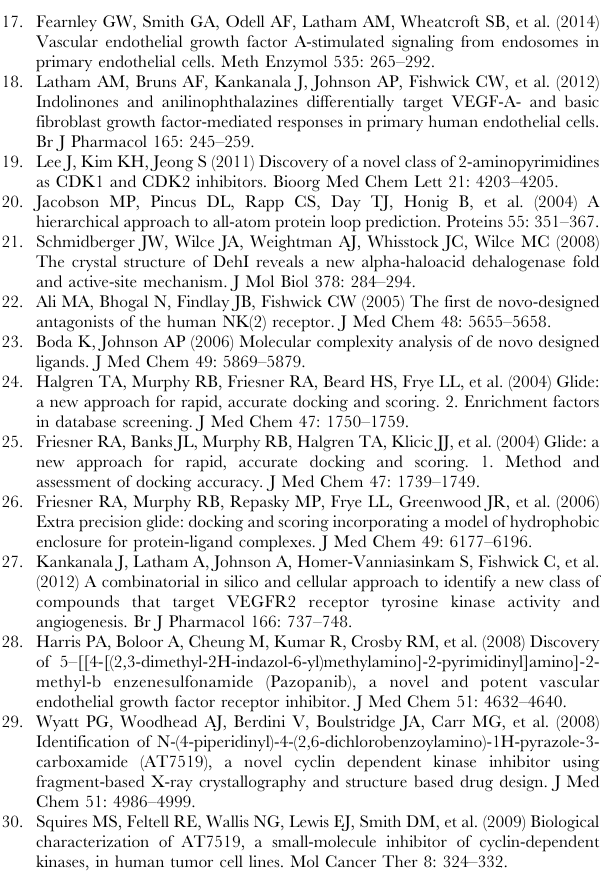
or (B) IGF-1-mediated signaling in endothelial cells. HUVECs were pre-treated with JK-31 (0, 0.1, 1, 10 or 50 m M) for 30 min followed by a 10 min stimulation with either (A) EGF (50 ng/ml) or (B) IGF-1 (100 ng/ml) in the presence of JK-31. Total cell lysates were prepared and processed for immunoblotting. Levels of phosphorylated Akt and ERK1/2 were analysed using phospho- specific antibodies. Membranes were stripped and re-probed for total protein levels and a loading control ( a -tubulin). Represen- tative immunoblots of three independent experiments are shown. (TIF) Figure S7 JK-31 does not compromise endothelial cell viability. (A) Relevant protein expression in HUVECs and MCF-7 cells. Total cell lysates were processed for immunoblotting. Membranes were probed with antibodies raised against VEGFR2, CDK1 and b -actin. Representative immunoblot was shown. (B) HUVECs were treated with DMSO or JK-31 (0.1, 1, 10, 50 m M) in full growth medium for 48 h followed by MTS assay and subsequent measurement of absorbance at OD 490 . Error bars represent 6 SEM (n= 5). Figure S8 Quantification of the effects of JK-31 on cell cycle status in endothelial cells. Quantification and statistical analysis of (A) phospho-CDK1, (B) CDK1, (C) Cyclin B, (D), Cyclin A and (E) Cyclin D1 levels in endothelial cells treated with nocodazole, bohemine, sutinib and JK-31 for 48 h. Statistics presented relative to ansyncronous controls. Error bars represent 6 SEM (n= 3). * p , 0.05; ** p , 0.01; *** p , 0.001. (TIF)